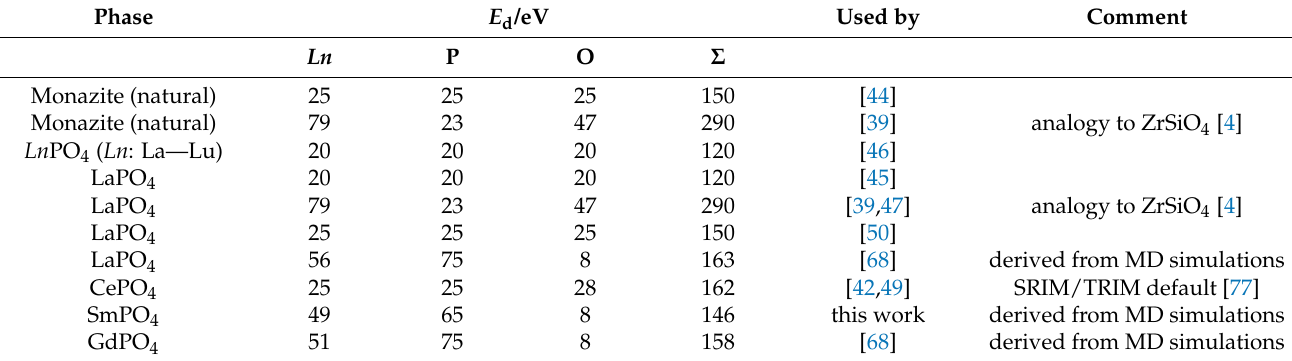
Table 6. Threshold displacement energies ( E d values) used in various studies on radiation effects